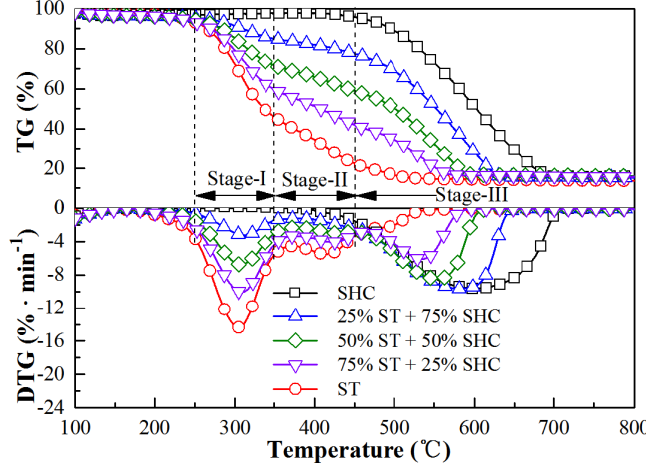
Figure 2. TG and DTG curves under different ST blending ratios (20 °C/min, 21%O 2 /79%%CO 2 ).